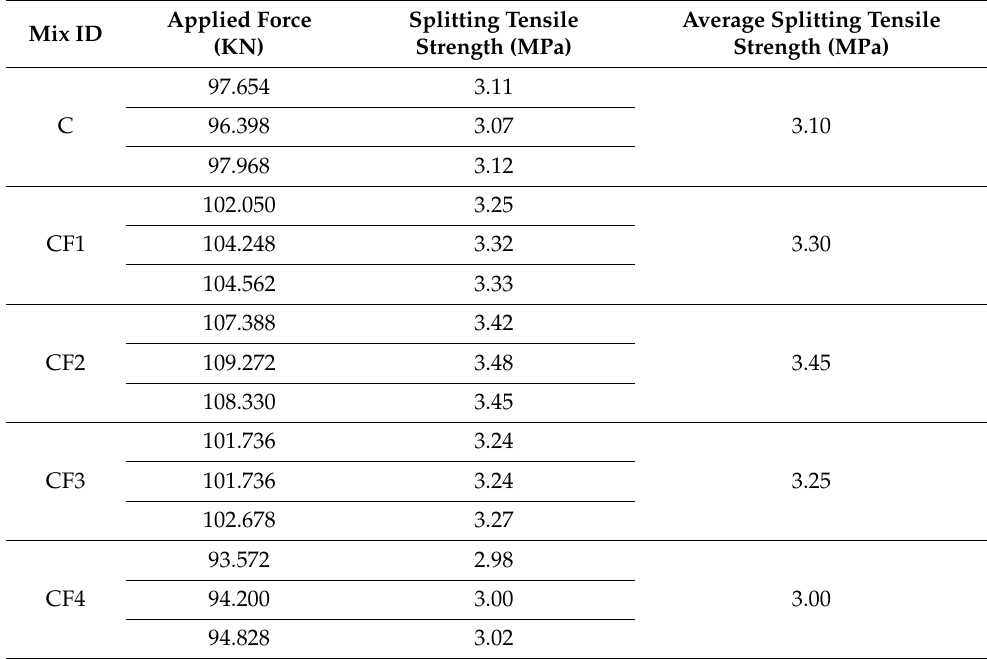
Figure 6. Development of splitting tensile strength of coir fiber-modified concrete. Table 6. Splitting tensile strength of concrete.